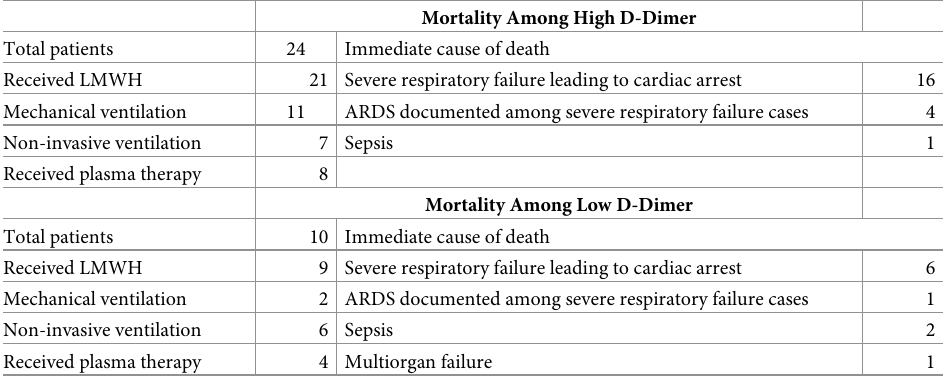
Table 5. Treatment received and immediate cause of death among patients with high and low D-dimer